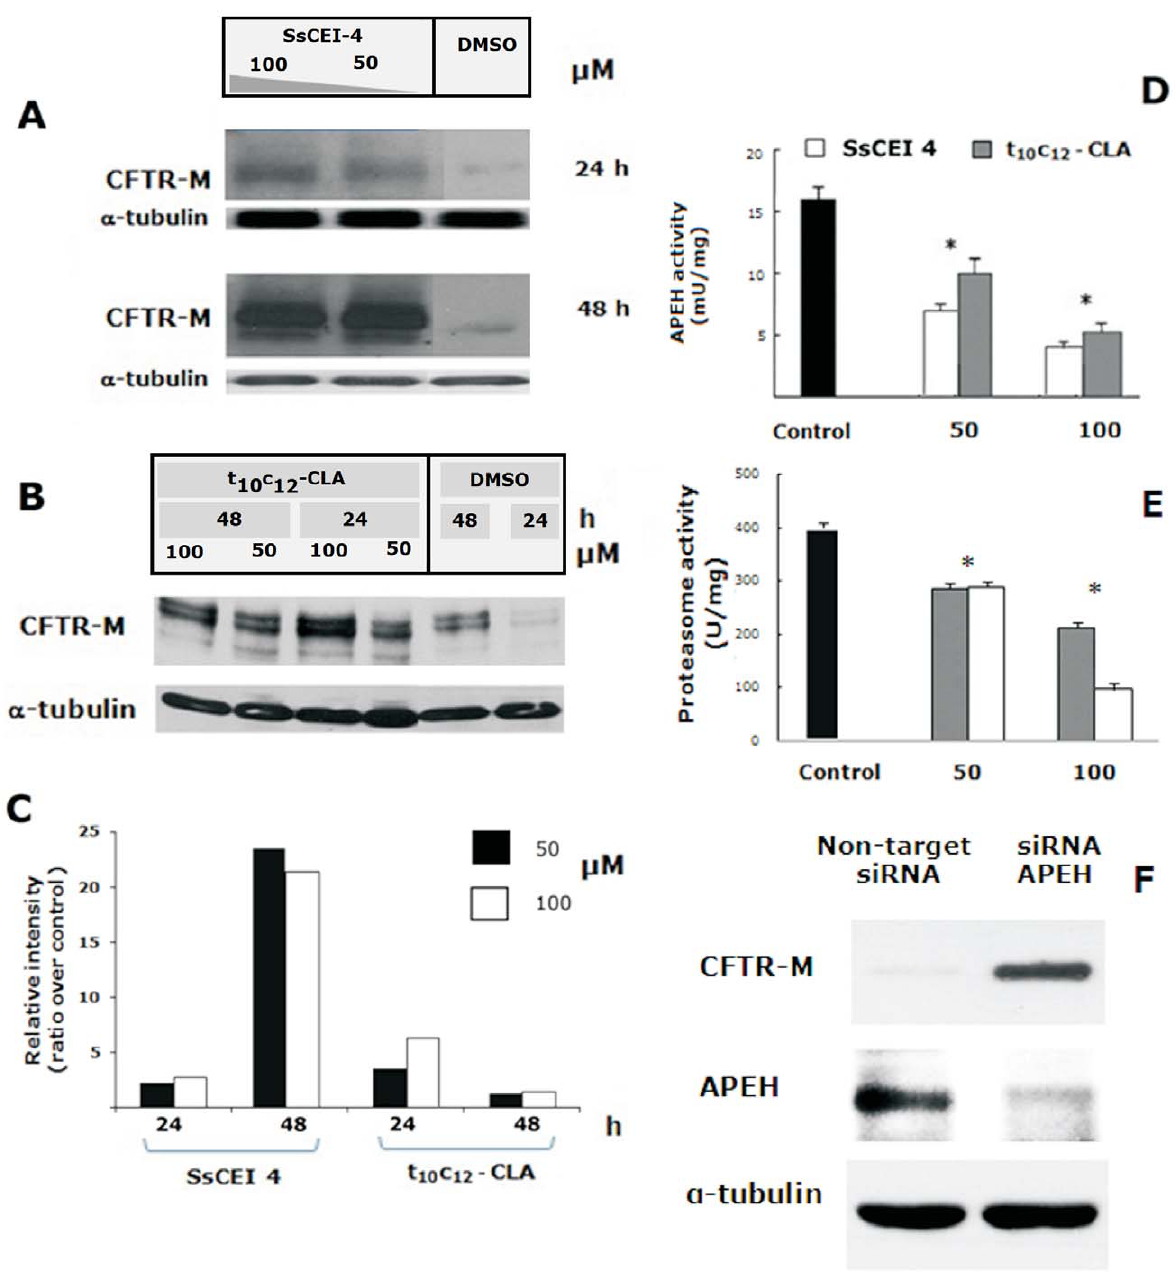
Figure 2. Analysis of the CFTR-M protein accumulation in BHK cells treated with the SsCEI 4 and t 10 c 12 -CLA and in APEH siRNA transfected CFBE41o-DF cells. Representative Immunoblots and associated densitometric analysis for cytosolic CFTR-M accumulation in BHK cells following 24 h and 48 h exposure to 50 m M or 100 m M SsCEI 4 (A), and to 50 m M or 100 m M t 10 c 12 -CLA (B). Bands were quantified using densitometric analysis and normalized against a -tubulin. The values were expressed as average fold increase as compared to untreated culture (C). APEH activity was measured in BHK cells incubated with 50 m M and 100 m M SsCEI 4 (white bars) or t 10 c 12 -CLA (grey bars) for 48 h (D). CT-like proteasome activities were measured in BHK cells incubated with 50 m M and 100 m M SsCEI 4 (white bars) or t10c12-CLA (gray bars) for 48 h (E). Untreated cultures were used as controls (black bars); the data are expressed as means 6 SD. *Significantly different (P , 0.005) from the control (D, E). Representative Immunoblots of APEH and CFTR-M accumulation in CFBE41o-DF cells transfected with APEH siRNA. A scrambled, non-targeted siRNA, was used as negative control and a -tubulin was used as loading control (F).